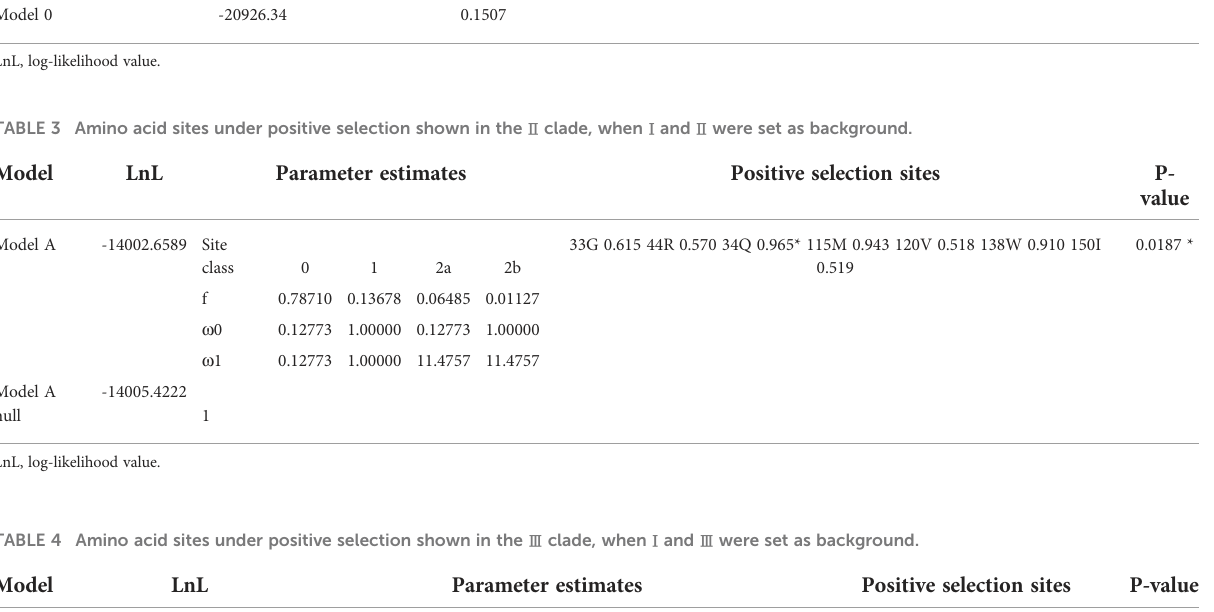
TABLE 4 Amino acid sites under positive selection shown in the Ⅲ clade, when Ⅰ and Ⅲ were set as background. Model LnL